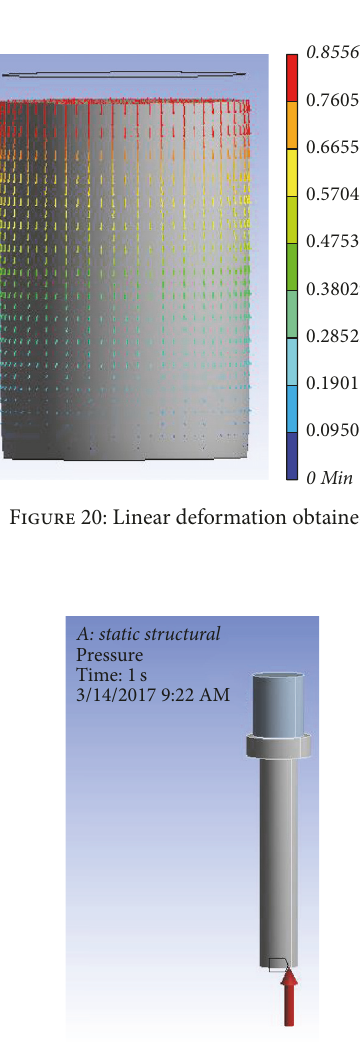
Figure 17: Linear deformation obtained.